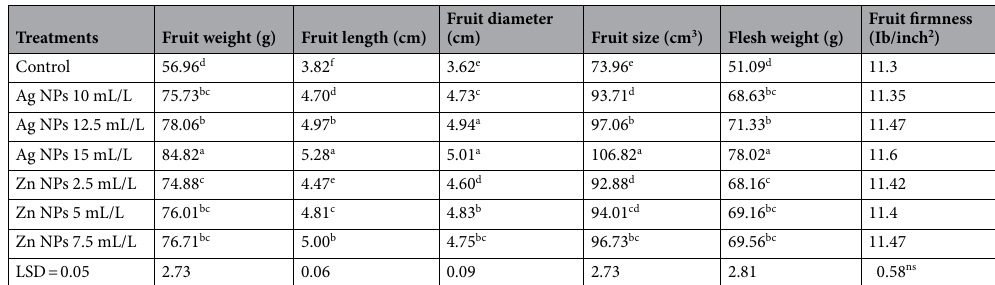
Table 2. Influence of spraying Ag and Zn NPs on weight, length, diameter, size, flesh weight, and firmness of fruit of “Florida prince” peach cultivar during 2020. *Means not sharing the same letter(s) within each column, significantly different at 0.05 level of probability. ns not significant.